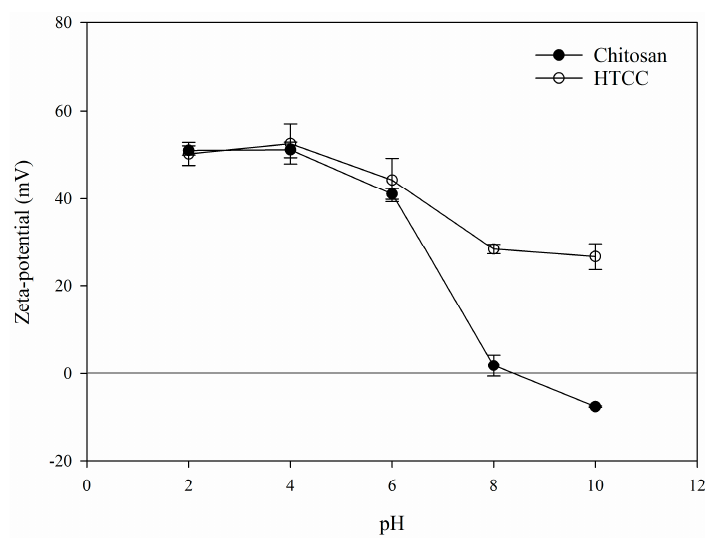
Figure 3. Zeta-potential profiles of chitosan and HTCC as a function of pH.